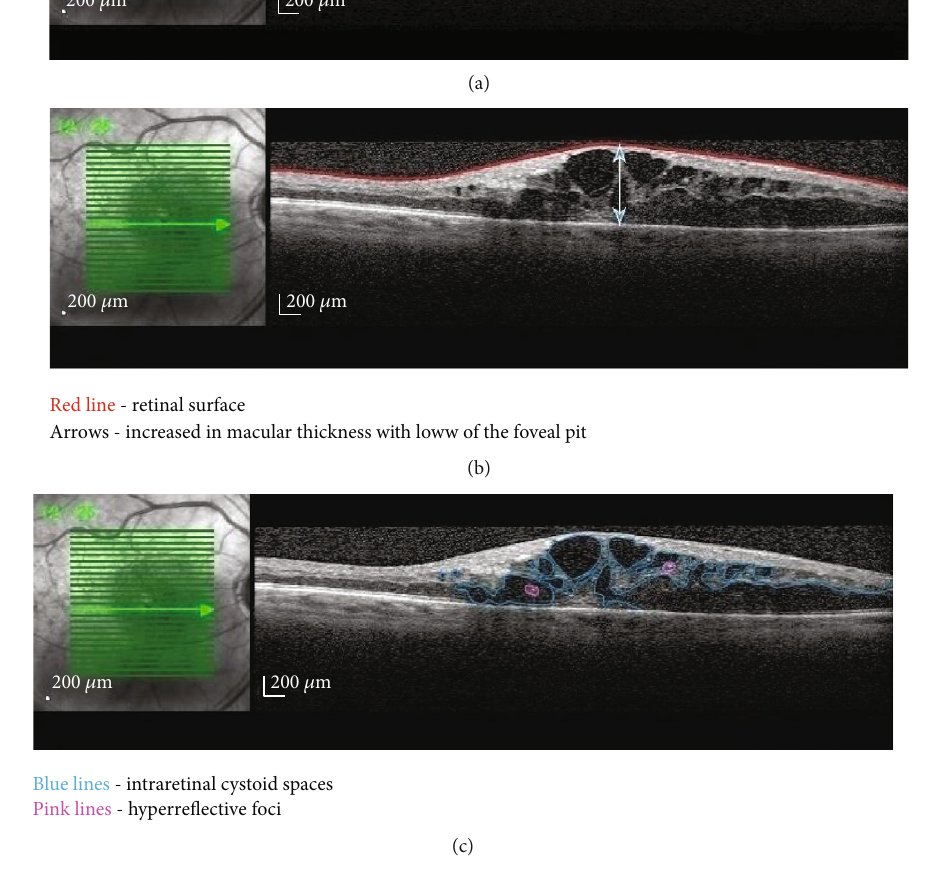
Figure 2: OCT aspects of the intraretinal cystoid spaces: (a) original OCT image; (b, c) highlighted lesions of the same